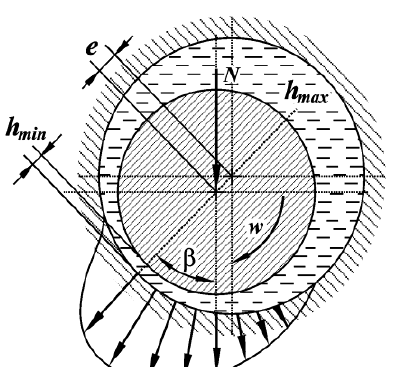
Fig. 5. Classical representation of the Hydro-Dynamic model of friction of a radial plain bearing, which illustrates the occurrence of pressure in the lubricating film (pressure diagram is shown as radial arrows, reflecting the effect of the "oil wedge"), at high shaft speeds ω, at low or moderate radial load N , where it is shown how the rotating shaft “floats up” and shifts in the direction of friction by the eccentricity e , and the axis of the shaft centers, on which the h and maximum h clearances of the radial bearing are located, is shifted by an angle minimum min max